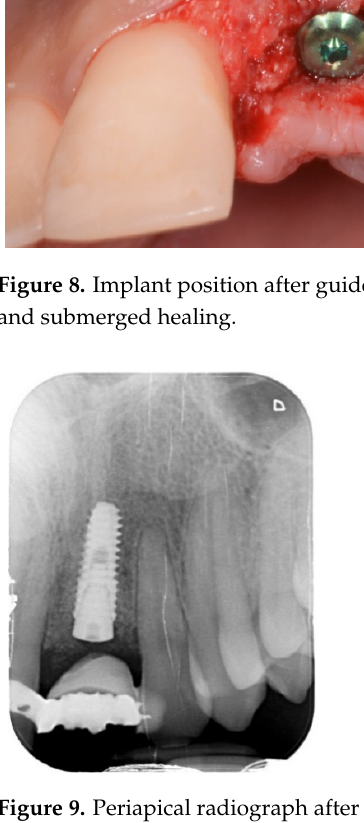
Figure 10. Papilla recession at the mesial area of the left maxillary lateral incisor two weeks after implant placement.